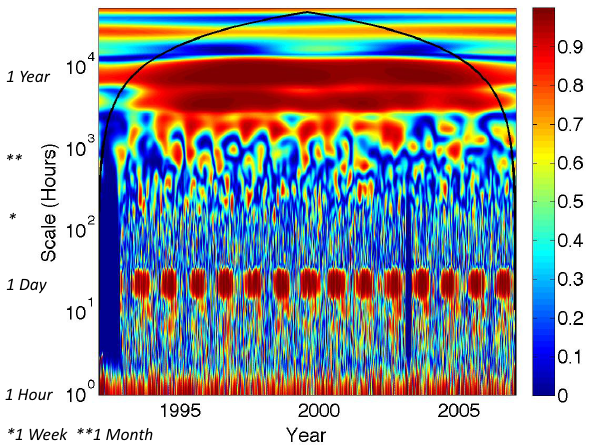
Fig. 2. Same as Fig. 1 but for regions of significant wavelet coher- ence between net ecosystem exchange (NEE) measurements at Har- vard Forest (US-Ha1) and the Ecosystem Demography v2 (ED2) model simulations, calculated following Grinsted et al. (2004). Re- gions in time and timescale with significant coherence are white and given a value of unity; regions without significant coherence are black and given the null